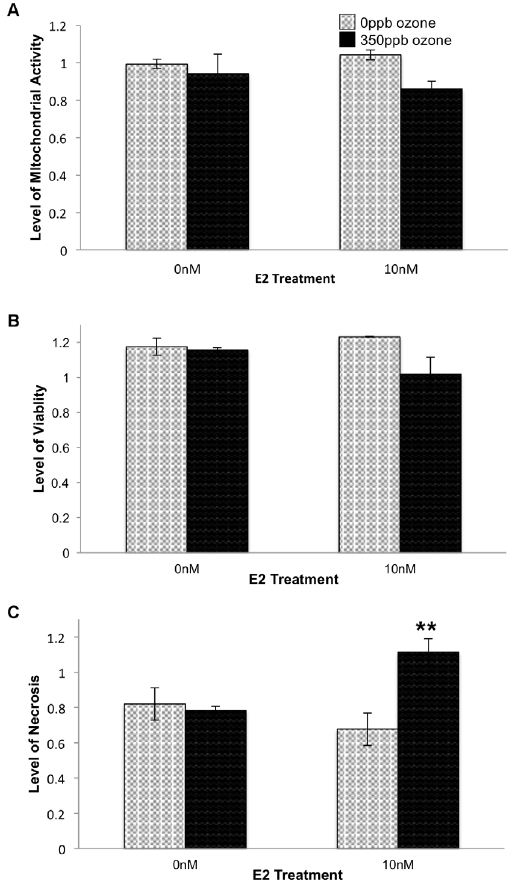
Figure 1. Effect of E2 and ozone (O 3 ) on relative levels of mitochondrial activity (A), viability (B) and necrosis (C) 0.5 hr after gas exposure. 10 4 L2 cells/well were treated with E2 and 350 ppb O 3 as indicated. After 0.5 hr recovery time, levels of mitochondrial activity (F= 1.7336, df =3,15, p = 0.2133), viability (F=2.6161, df=3,12, p=0.1152), and necrosis (F=7.4798, df=3,12, p=0.0081) were determined. Values represent the mean of 3–4 replicates normalized to data from control cells (-E2, in non-flowing 5% CO 2 /air), 6 S.E.M. # p # 0.05 compared to 0 ppb O 3 . ** p # 0.01 compared to the same E2 treatment